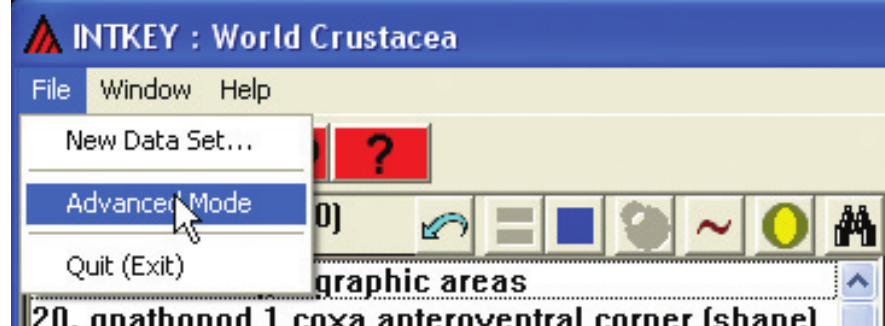
Figure 44. Selecting the Best order of characters.